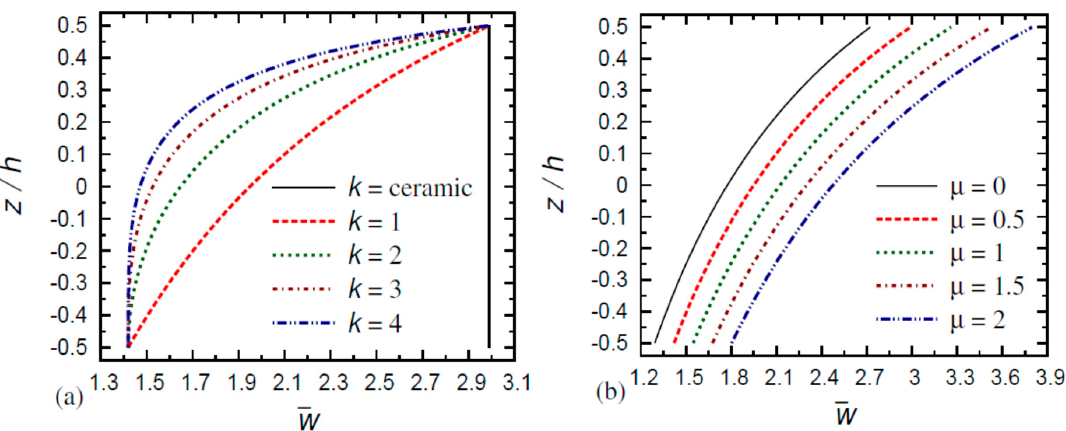
Figure 3. Variation in non-dimensional displacements (cid:1875)(cid:3365) of FG square nanoplates versus the thickness ratio (cid:1853)/ℎ , (cid:1878)/ℎ = 0 ( a ) for different values of (cid:1863) ( (cid:2020) = 0.5 ) and ( b ) for different values of (cid:2020) ( (cid:1863) = 1 ).